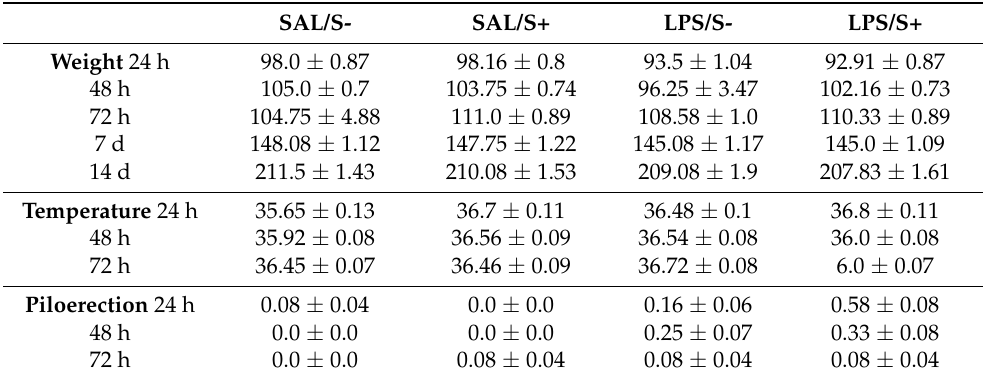
Table 1. Mean values of sickness assessment measures (weight, temperature and piloerection) 24, 48, and 72 hours (h), 7, and 14 days (s) after LPS exposure. No evidence of the remaining signs of sickness (tremor, hunched/flat posture, lacrimation, salivation, or diarrhea) was found. Data are represented as mean ± SEM.